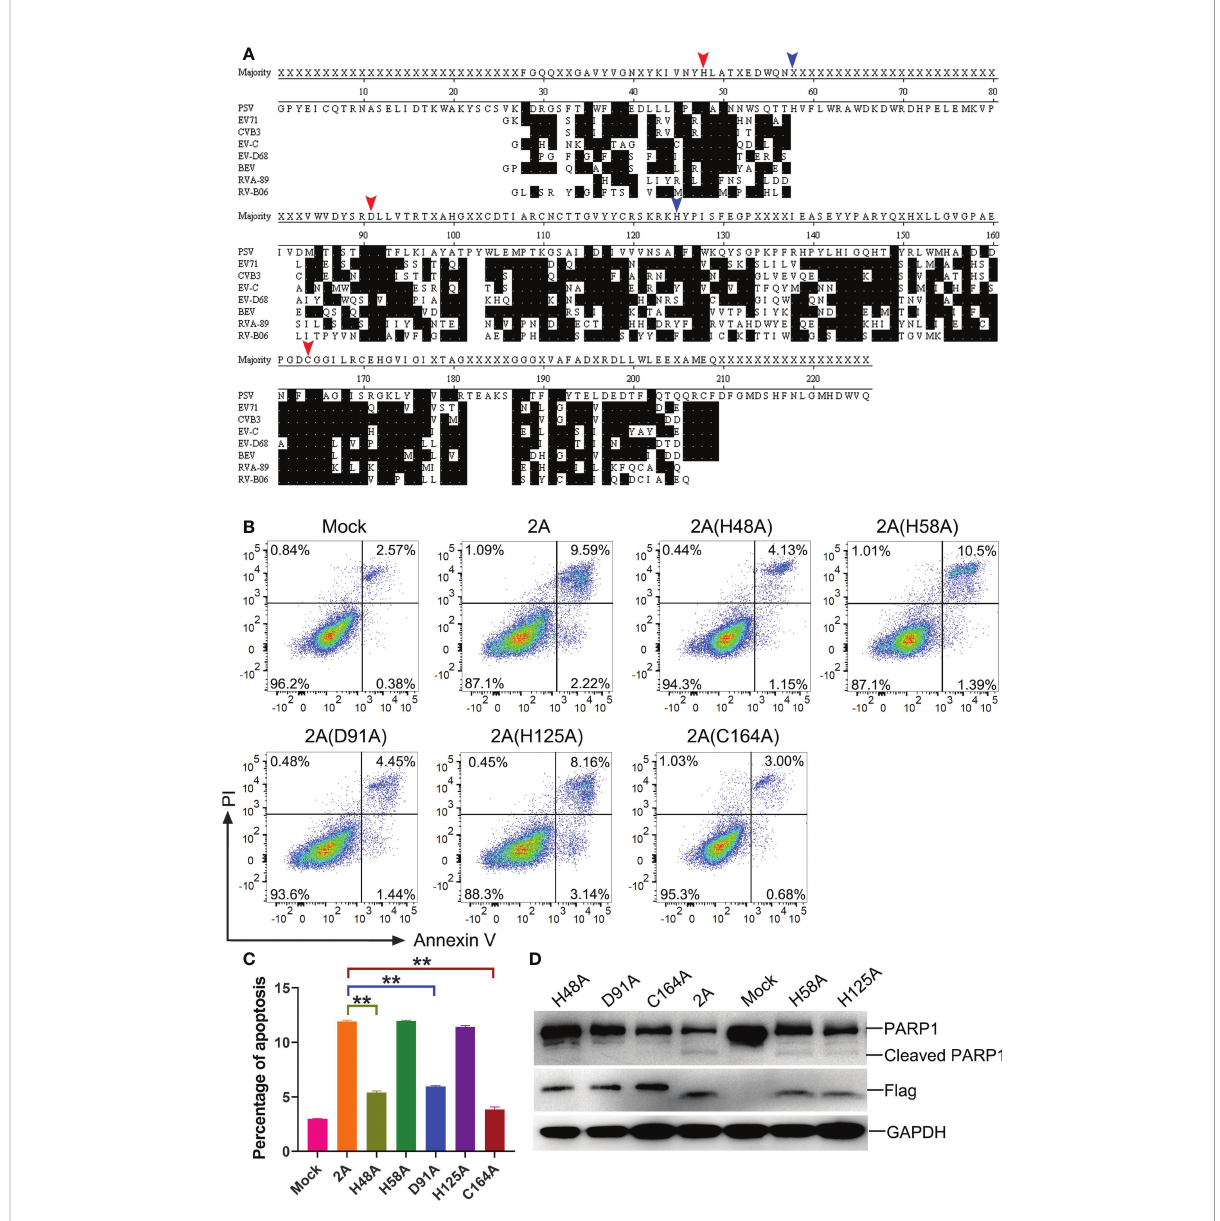
FIGURE 8 The crucial residues of PSV 2A for inducing the apoptosis. (A) The amino acid alignments of 2A in representative members of picornaviruses were listed. Identical residues are indicated by dots on black background. The residues marked with red arrow represent the amino acids that form the catalytic triad of poliovirus 2A. The residues marked with blue arrow are other amino acids selected as control. Residues are numbered according to the amino acid sequence of EV71 MH685713, CVB3 MF678329, EV-C NP_740477.1, EV-D68 KX351830, BEV NC_001859, RVA-89 NC_001617, and RV-B06 JX193795. (B, C) The HEK293A cells were transfected with pCAGGS-Flag-2A and its mutants: pCAGGS-Flag-2A(H48A), pCAGGS-Flag-2A(H58A), pCAGGS-Flag-2A(D91A), pCAGGS-Flag-2A(H125A), and pCAGGS-Flag-2A(C164A), after 24 h, the cells were collected and subjected to dual Annexin V and PI labelling, sequentially, detected by fl ow cytometry. The graph represented the percentage of Annexin V positive quadrants (n = 3). **P < 0.01. (D) HEK293A cells were transfected with pCAGGS-Flag-2A and its mutants for 24 h. Then the cellular lysates were analyzed through western blot with antibodies against Flag and